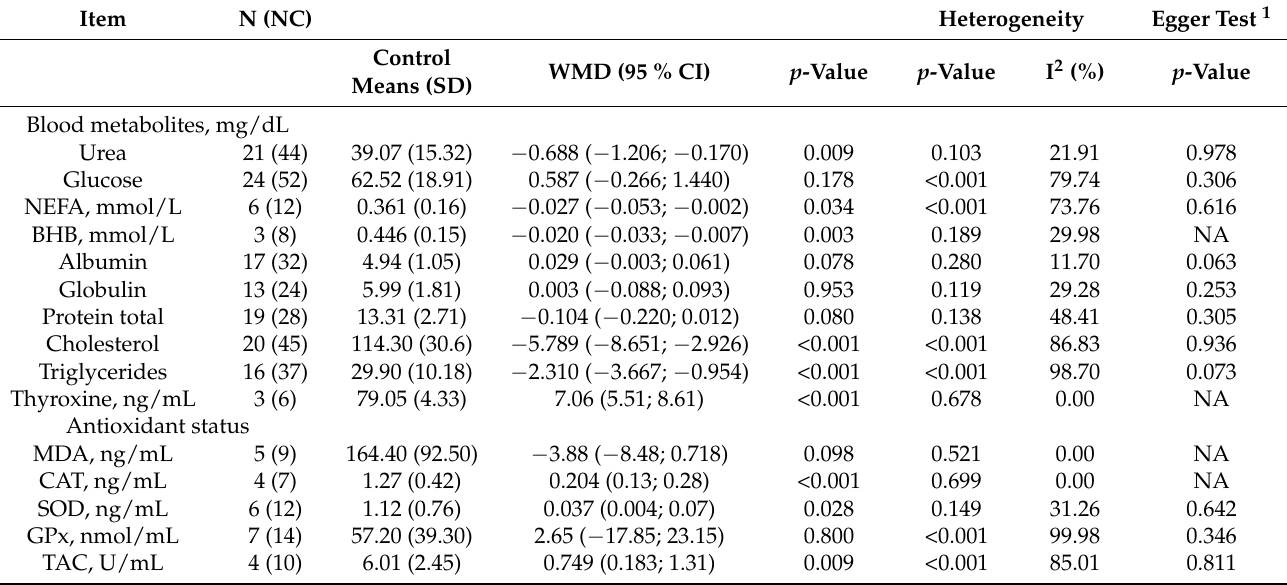
Table 5. Blood metabolites and antioxidant enzymes in blood serum of small ruminants supplemented with essential